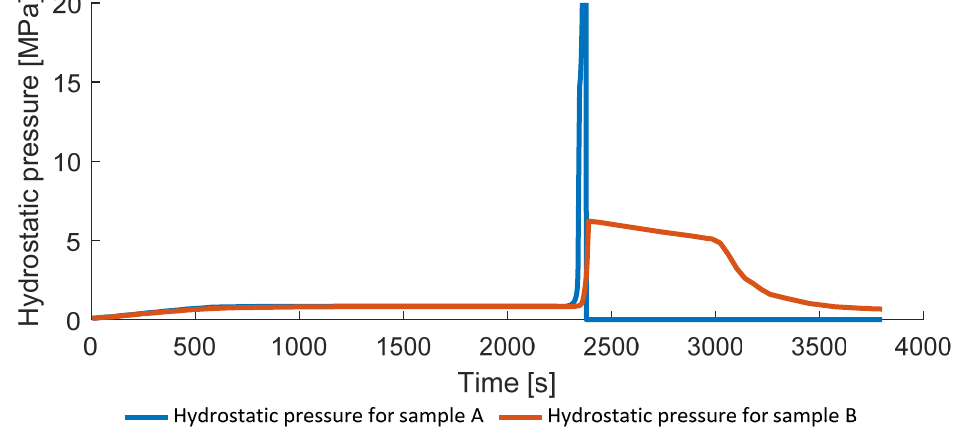
Figure 15. Hydrostatic void pressure.